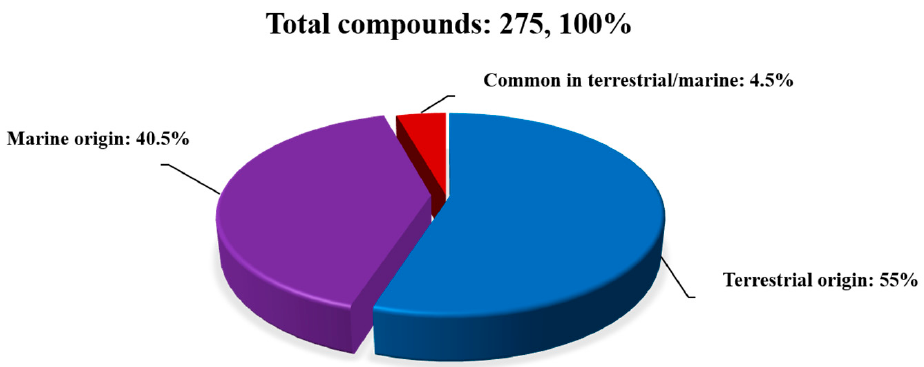
Figure 9. Total number of compounds isolated from genus Diaporthe .